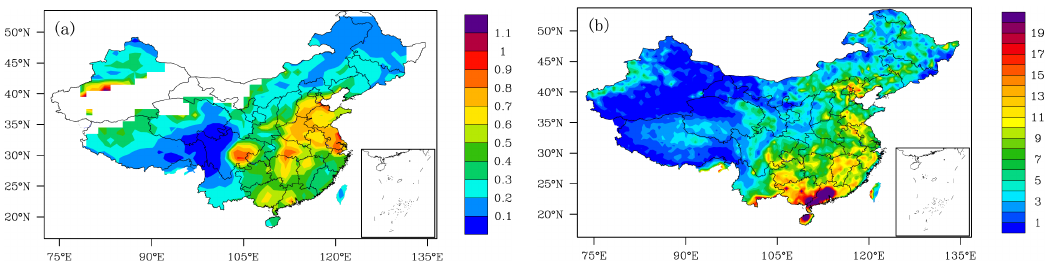
Figure 1. Annual mean ( a ) aerosol optical depth at 550 nm (AOD) and ( b ) lightning flash density (flashes km − 2 ·year − 1 ) over China calculated from 2001 to 2012.